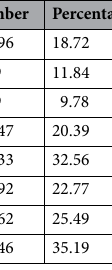
Table 3. Function annotation of A. konjac buds transcriptome.